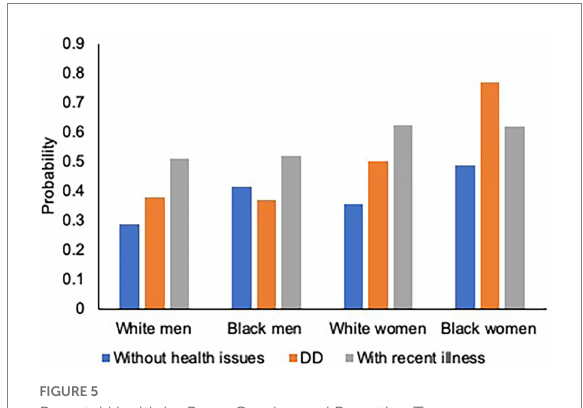
FIGURE 5 Parental Health by Race, Gender, and Parenting Type: Depression. Figure was based on the three-way interaction results in Table 5. Controlled for covariates and cumulative early life adversities (ELAs). DD refers to DD: Developmentally